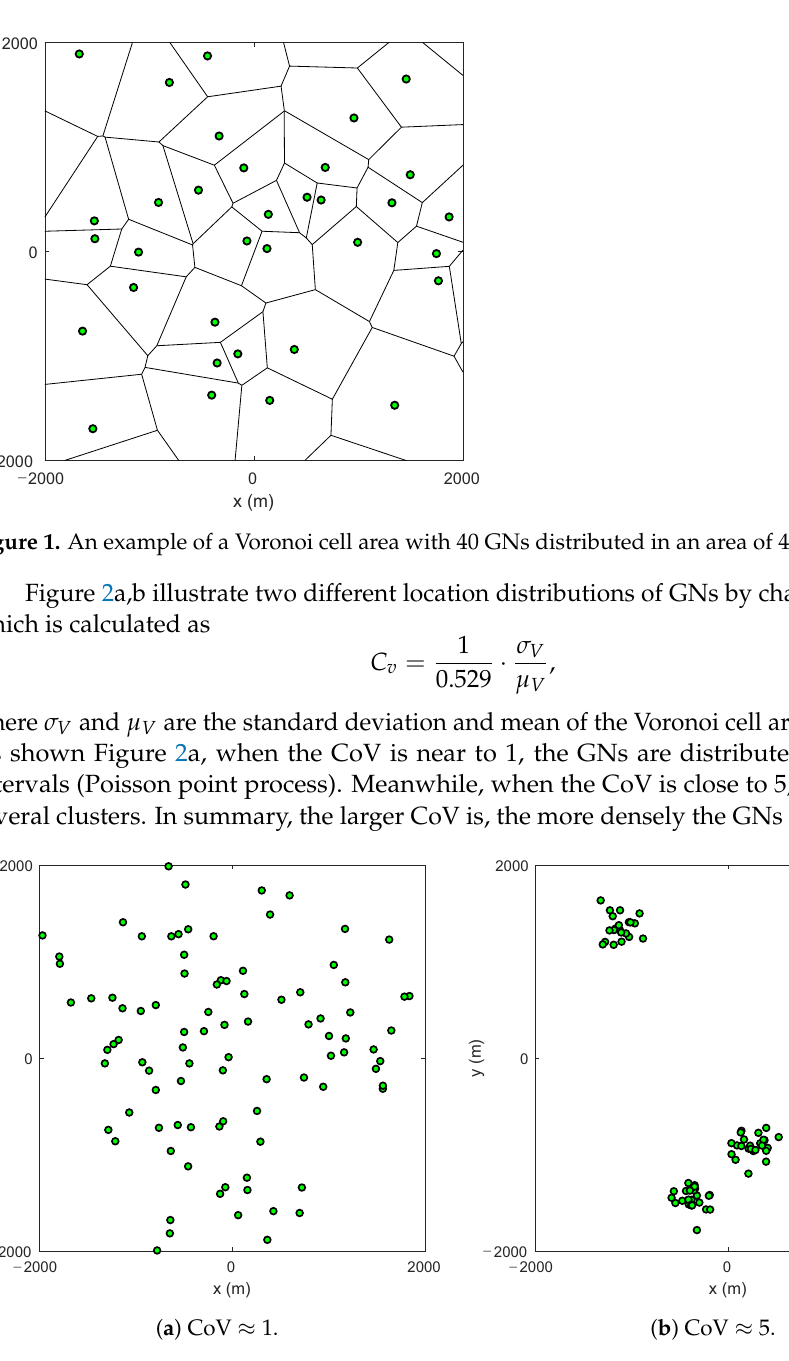
Figure 2. The location distribution of 100 GNs for different values of CoV; a = 4000